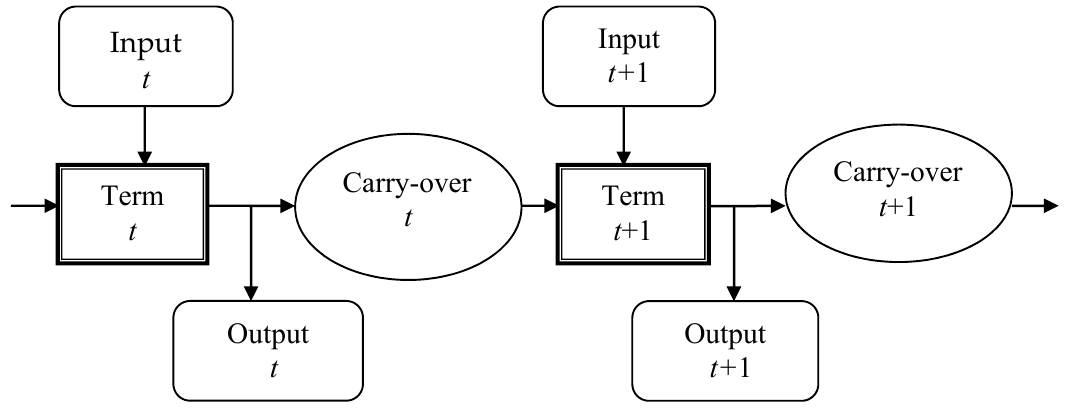
Figure 2. The structure of dynamic data envelopment analysis (DEA).